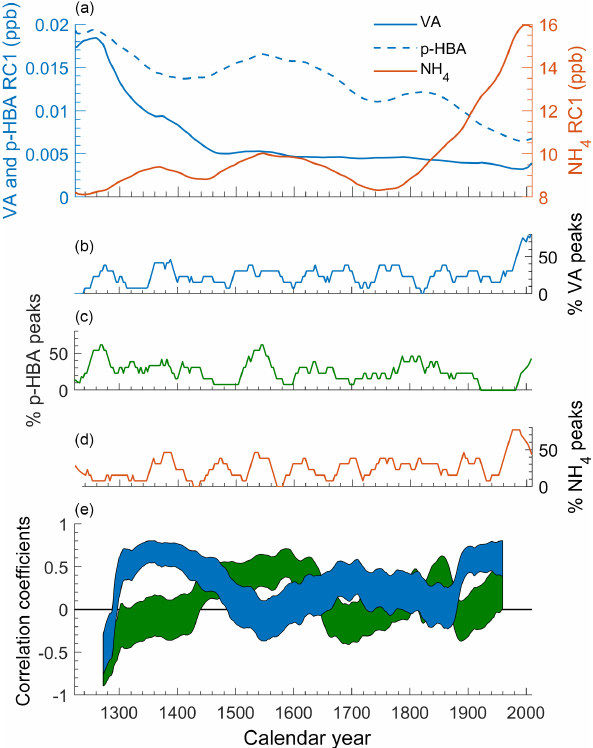
Figure 5. Relationships between Lomonosovfonna vanillic acid (VA), p -hydroxybenzoic acid ( p -HBA), and ammonium (NH 4 ) us- ing 3-year bin-averaged data. (a) First component from the singu- lar spectrum analysis of VA (blue solid line), p -HBA (blue dashed line), and NH 4 (orange line) (PC1) reconstructed into concentration units (RC1, ppb), (b, c, d) Frequency of peaks in the ice core sig- nals reconstructed using singular spectrum components 2–30 and peak threshold of 75th percentile, smoothed with a 40-year running window. (e) Correlation coefficients for the ice core peak frequen- cies using a 200-year running window ( p < 0 . 001). Bands are the 95% confidence intervals of the correlation coefficients of VA and ammonium (blue) and p -HBA and ammonium